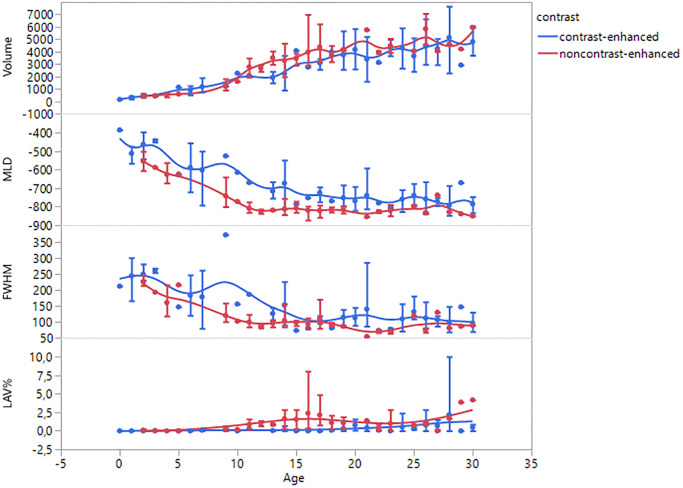
qCT parameters against age.Shown are the mean changes in the four measured parameters of the age of the patients with standard deviation and smoothed trend lines. As shown, while volume and emphysema percentage (LAV) rise over time, mean lung density (MLD) and the full width at half maximum of the volume density histogram (FWHM) decline.